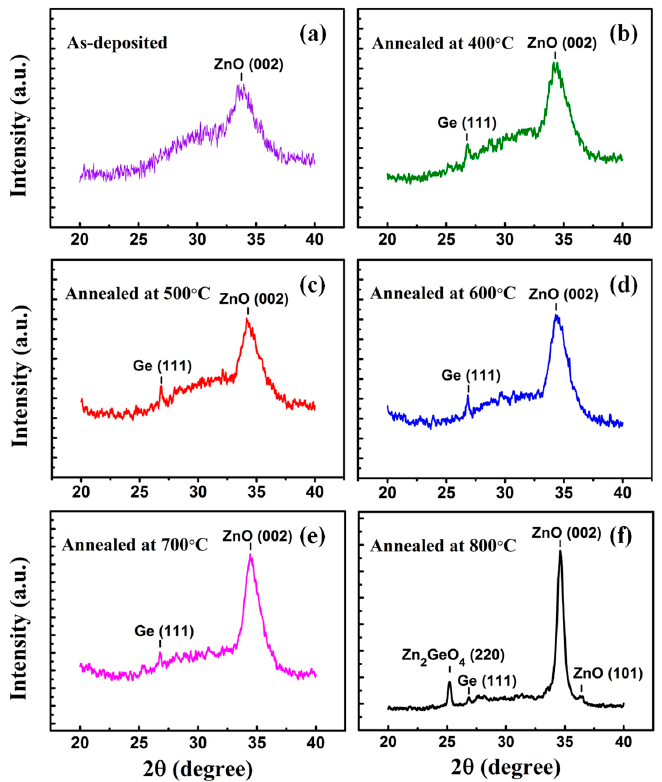
Figure 1. X-ray diffraction (XRD) patterns of ( a ) as-deposited Ge:Er:ZnO; Ge:Er:ZnO films annealed at ( b ) 400 ◦ C; ( c ) 500 ◦ C; ( d ) 600 ◦ C; ( e ) 700 ◦ C; ( f ) 800 ◦ C.